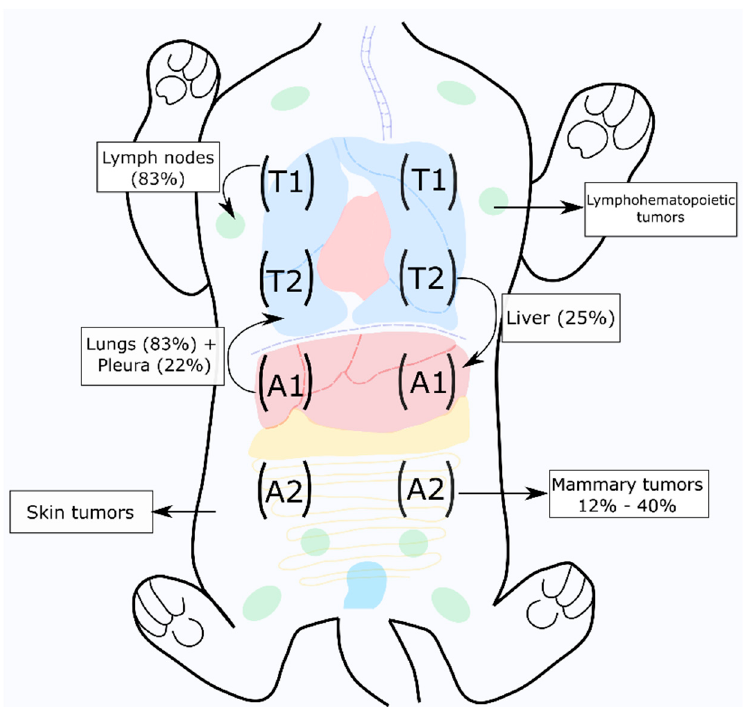
Figure 1. Mammary carcinoma is the third most common tumor in cats, with a high metastasis rate, frequently to lymph nodes and lungs [17,31]. The black arrows indicate the most frequent tumor locations and metastasis pattern.